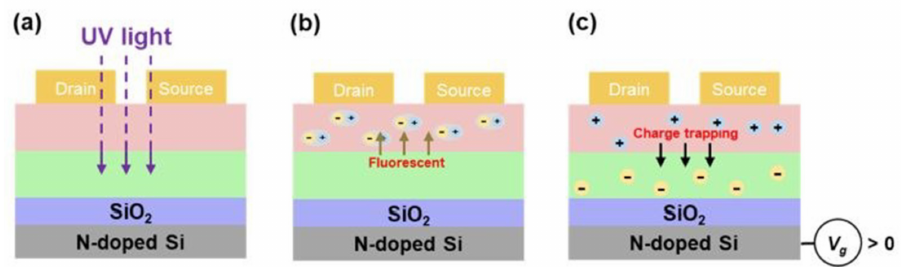
Figure 21. Schematic diagram of programming process of OPT, ( a ) OPT under the UV light, ( b ) the photoinduced excitons in pentacene, ( c ) charge trapping under reverse bias. Reprinted with permission from ref. [157]. Copyright 2019 Royal Society of